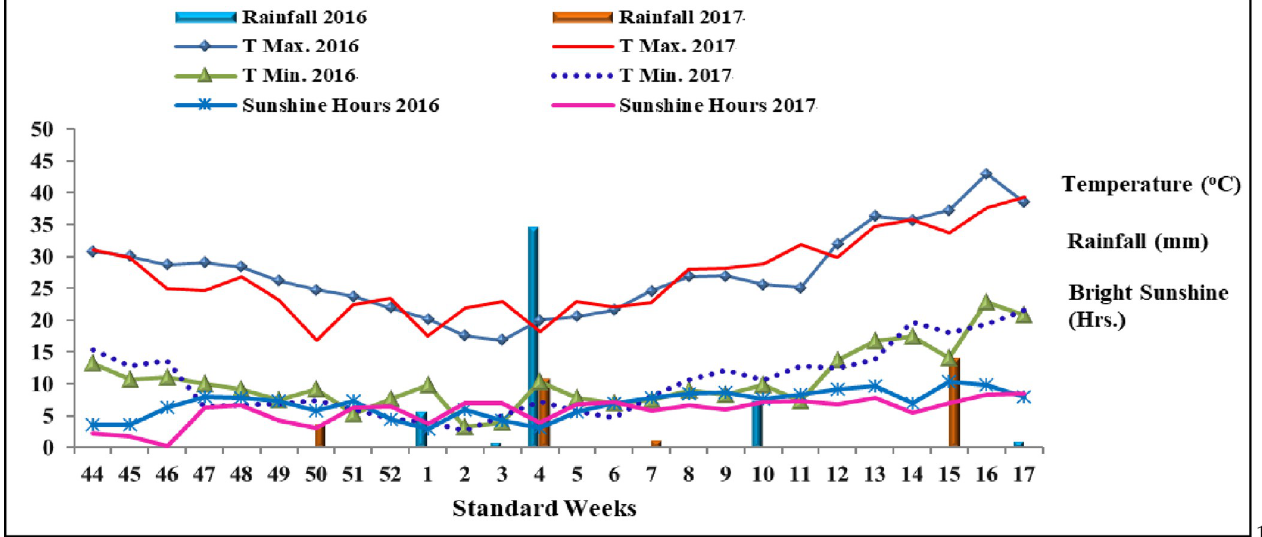
Fig 1. The average weather data of standard meteorological weeks of 2016 and 2017 during the crop duration.